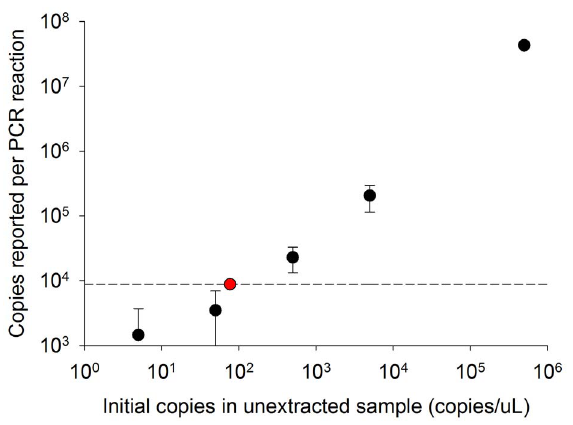
Figure 7. DNA recovery is significantly increased with increas- ing DNA sequence length (mean 6 s.d., n=3). * denotes